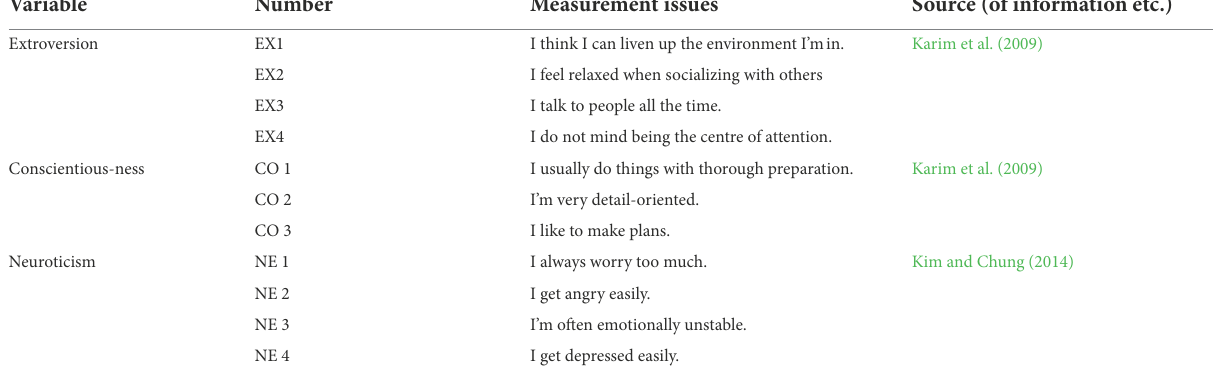
TABLE 1 User personality traits scale.